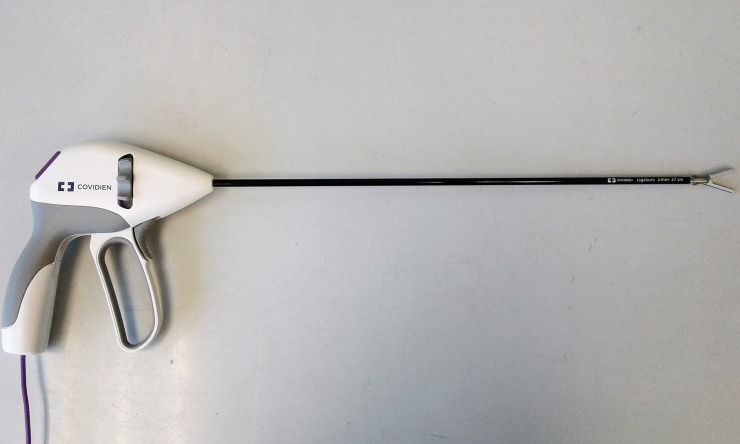
LigaSure device.